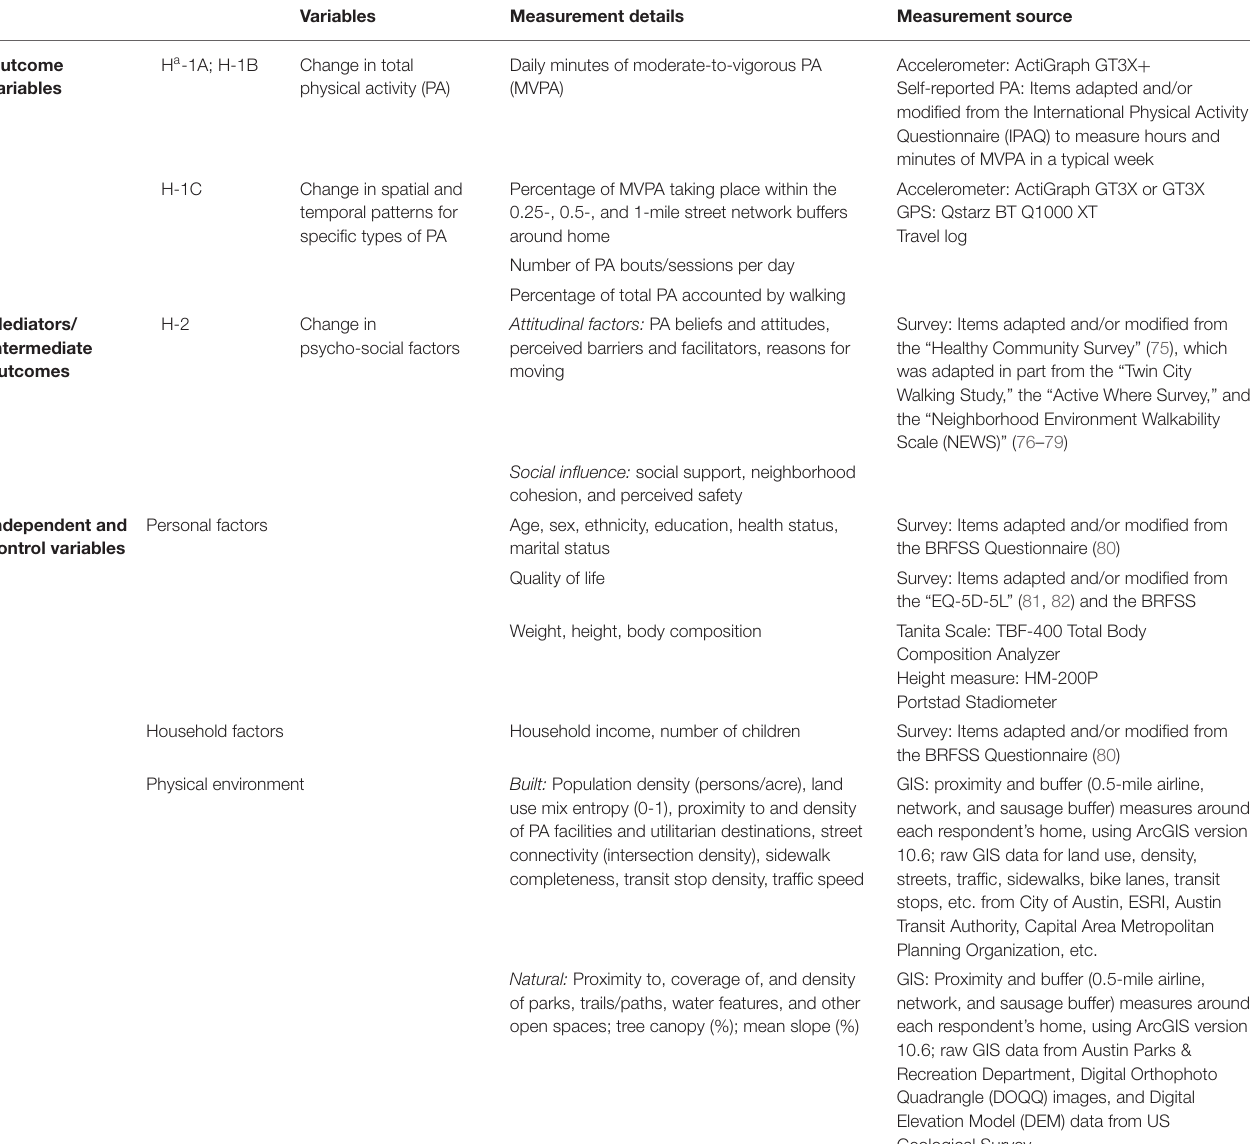
TABLE 2 | Study variables and measurement